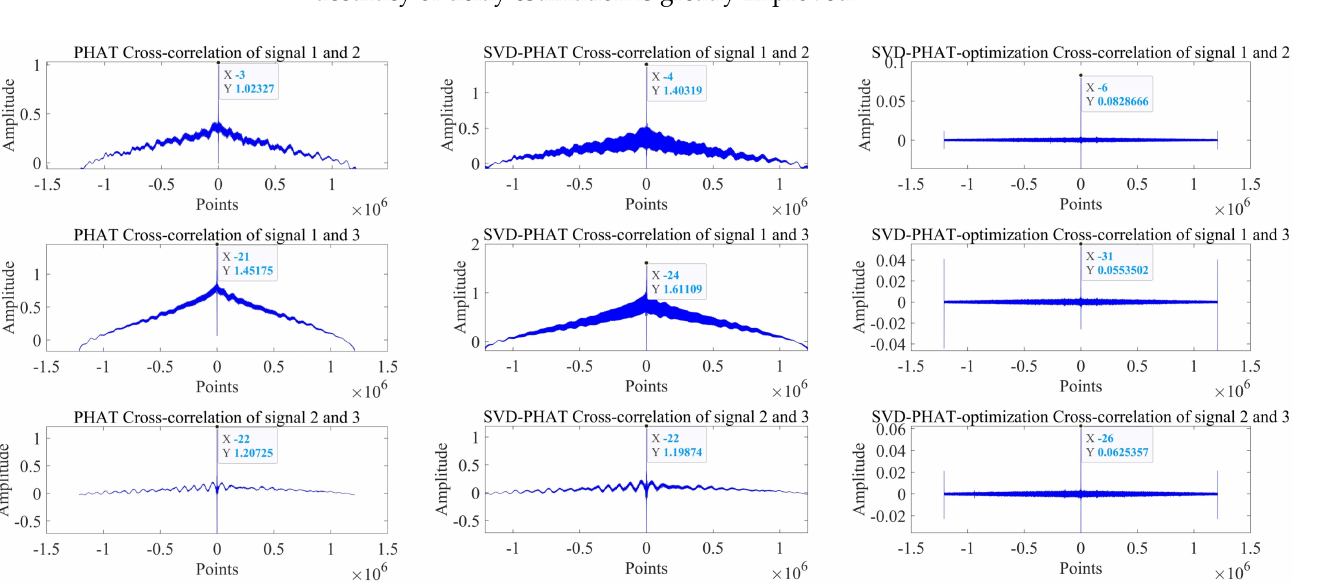
Figure 19. Delay estimation performance of GCC-PHAT weighting, SVD-GCC-PHAT weighting and SVD-GCC-PHAT- ργ